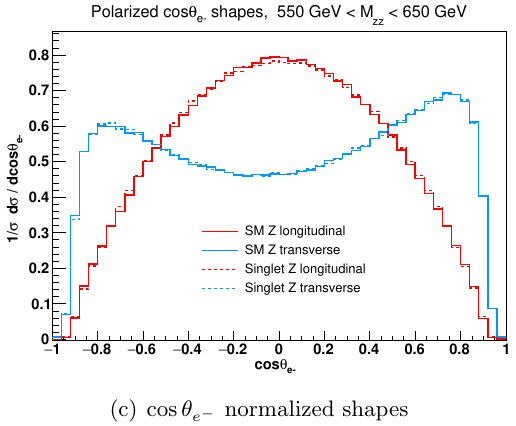
Figure 15 . ZZ scattering: comparison of Standard Model (solid) and Singlet (dashed) distributions in M ZZ and cos (cid:18) , in the heavy Higgs resonance region ( M H = 600 GeV). The full set of kinematic e (cid:0) cuts (see section 4.1) is